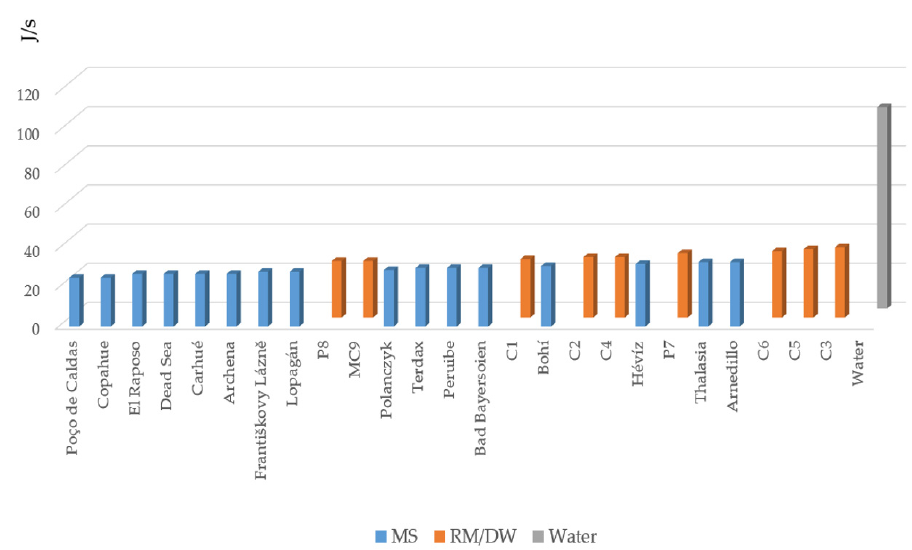
Figure 4. Heat flows recorded for the RM/DW formulations, distilled water and MS.